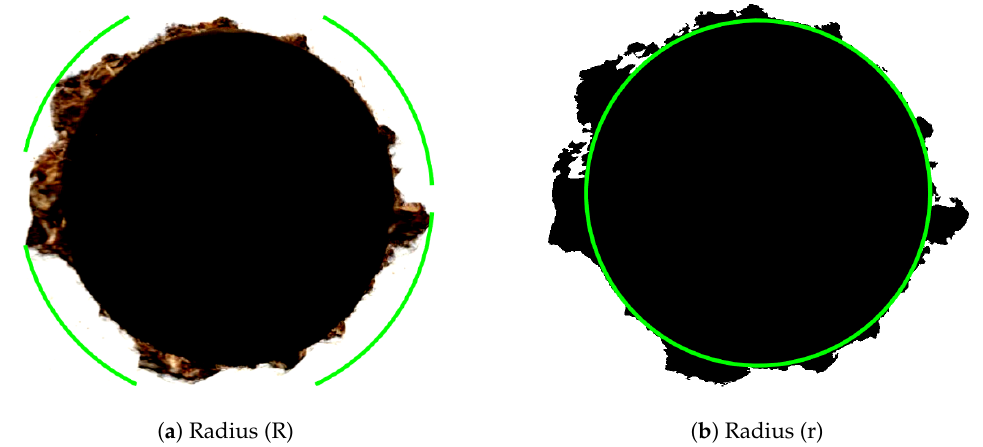
Figure 6. Comparison of hole radius—circumscribed ( a ) and inscribed ( b )